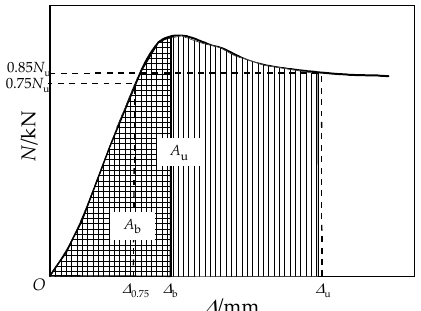
Figure 14. Typical load–displacement curve.